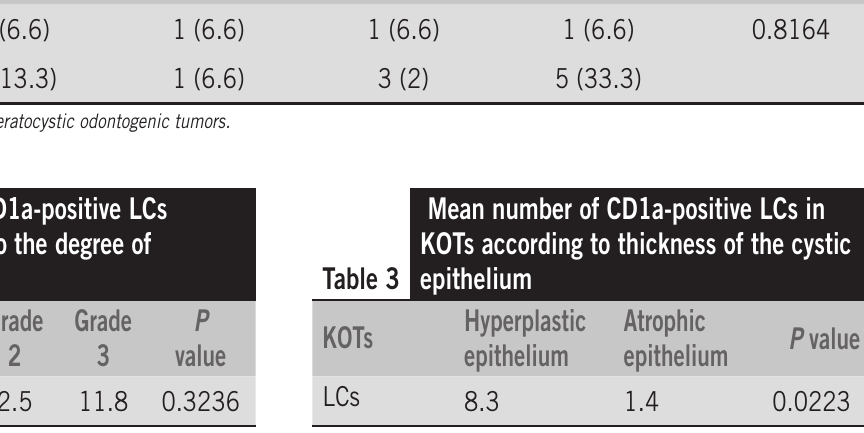
Frequency of cases of KOTs according to thickness of the cystic epithelium and degree of inflammation Grade 0 – n (%)